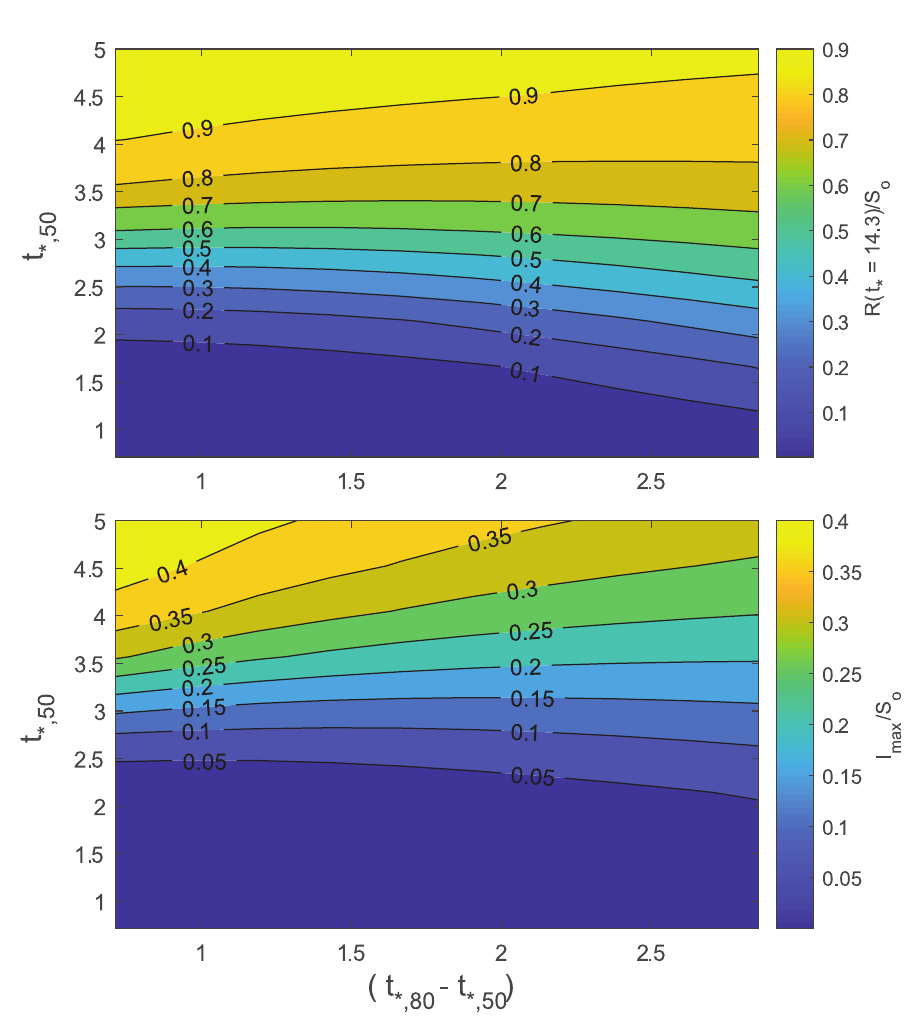
Fig 12. Variation in cumulative number of infected relative to S o (top) and in maximum number of infected relative to S (bottom). The logistic form of R o The t � ,50 and t � ,80 are the dimensionless times at which R o is half and 80% through the the total